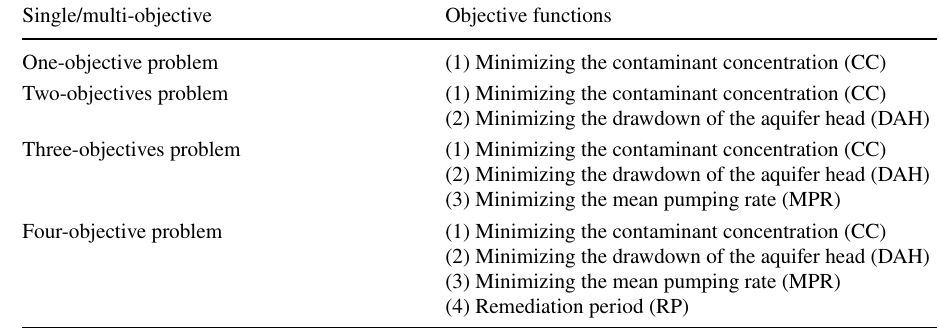
Table 3 Optimization problems and their